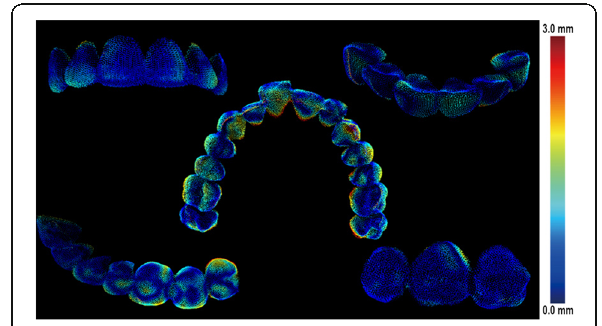
Fig. 10 Color map of the superimposed 3D dataset within the genuine pairs